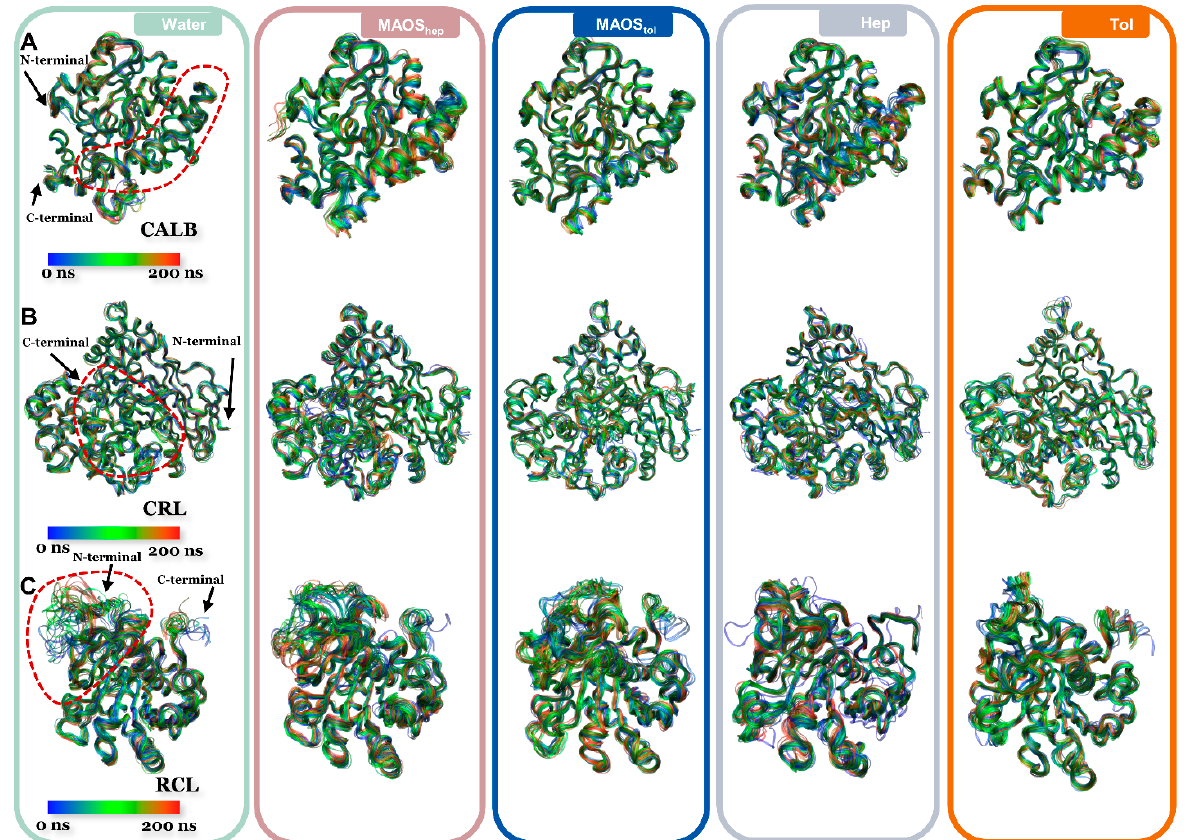
Figure 1. Snapshots of CALB backbones ( A ), CRL backbones ( B ) and RCL backbones ( C ) at different instants in water (green box), MAOS hep (pinkbox), MAOS tol (blue box), n-heptane (ice-blue box), toluene (orange box). The time scale ranges from 0 ns to 200 ns and corresponds to blue-green-red colors. The regions denoted by red dashed lines represent the flexible regions observed during MD simulations in various solvent systems. Both terminus and the flexible regions of the lipases are only shown in the water system.